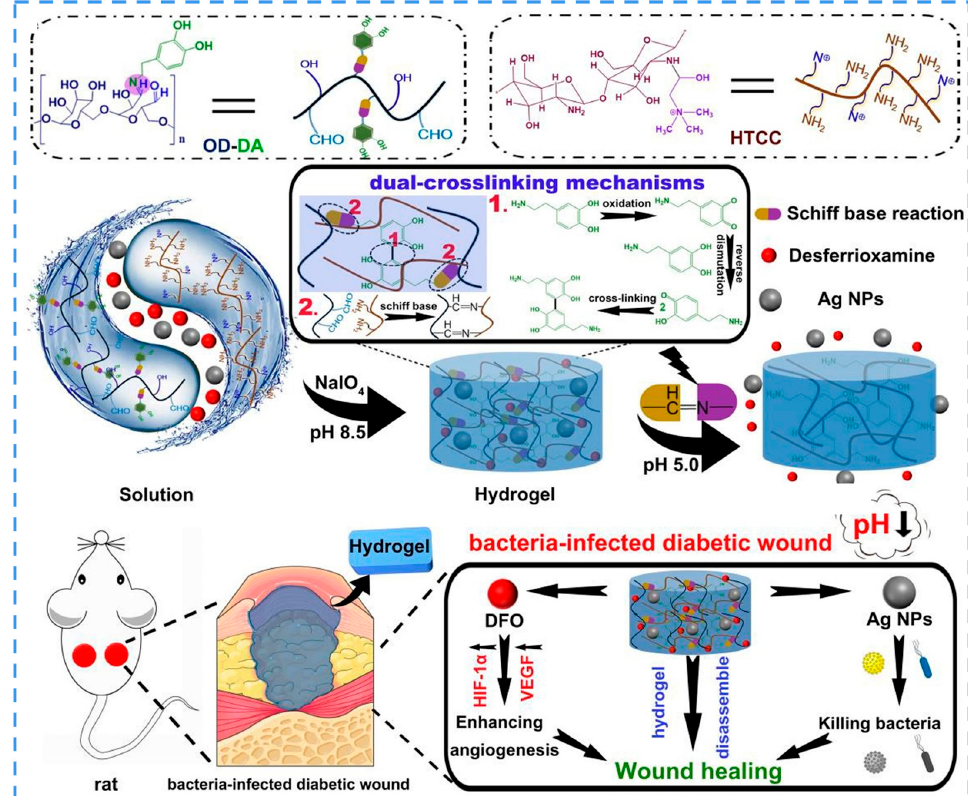
Figure 9. Schematics of the formation and mechanisms of hydrogel Ag NPs@HTCC/ODEX-DA (ODEX-DA = OD-DA), and the antibacterial and wound healing mechanisms including enhancing angiogenesis and killing bacteria. Adapted with permission [178]. Copyright 2021, Elsevier.